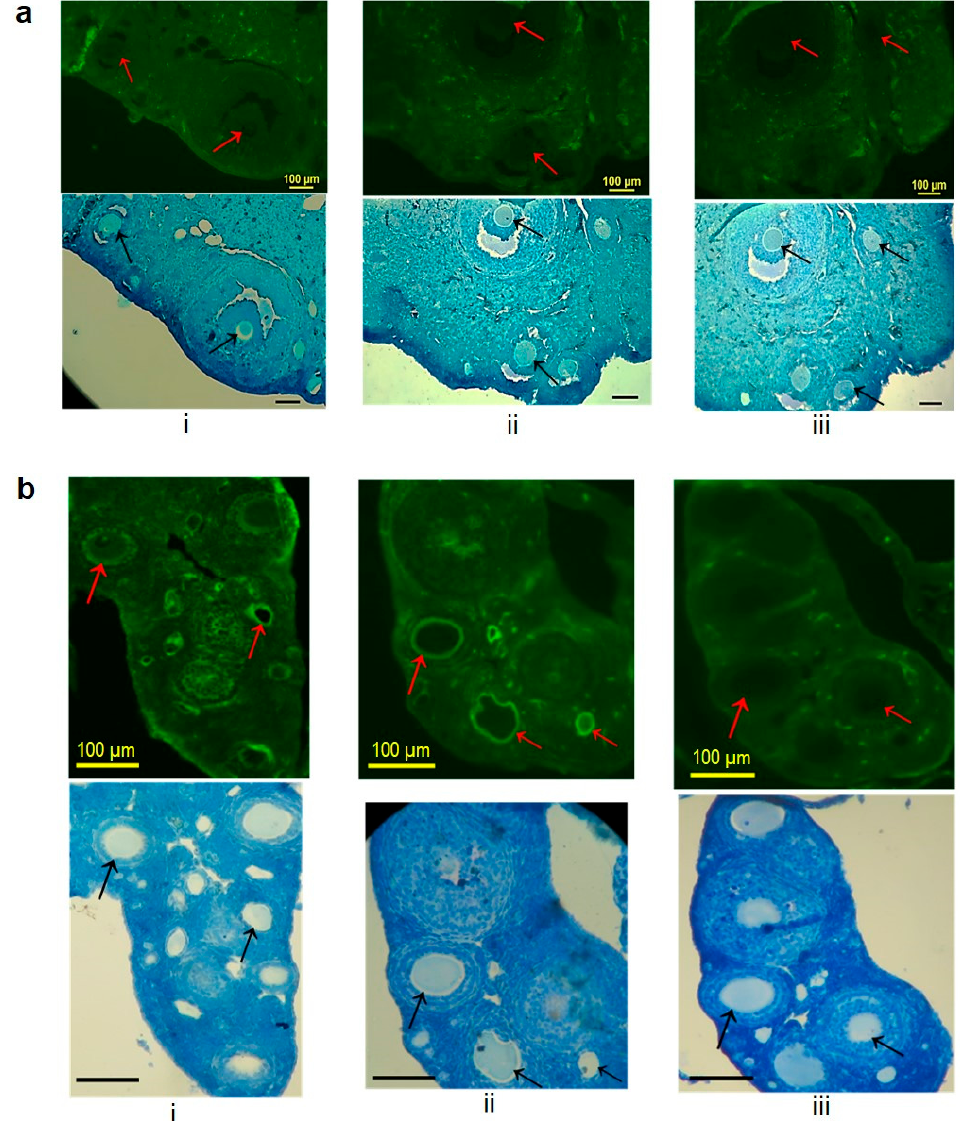
Figure 9. Indirect immunofluorescence microscopy for detecting the reactivity of serum antibodies with zona pellucida matrix in ovarian sections. Ovarian sections from BALB/c mouse ( a ) and wild mouse ( b ) treated with sera from mice immunized with GFP-mZP3-1 (i) and mZP3-3 (ii). Control experiments were performed with pre-immune sera of mZP3-3-immunized mice (iii). The upper pictures show sections in the fluorescent field, and the lower pictures represent stained sections in the bright field. Arrows represent the zona pellucida. Scale bars = 100 μ m.